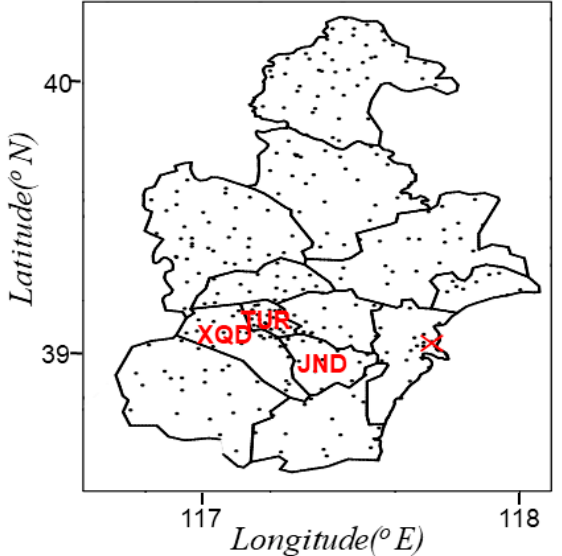
Figure 1. Distribution of weather observations (dots) used for this research and the position of the Doppler Radar in the Tanggu District (red cross). The district names of Tianjin are abbreviated on the map as follows: TUR (Tianjin urban region), XQD (Xiqing District) and JND (Jinnan District).